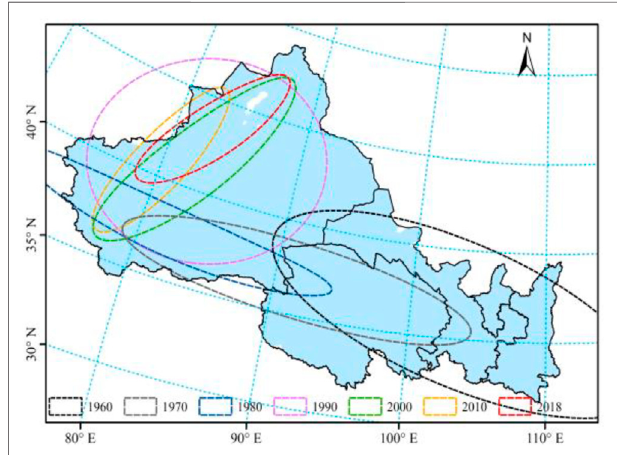
FIGURE 8 | Standard deviation ellipse of